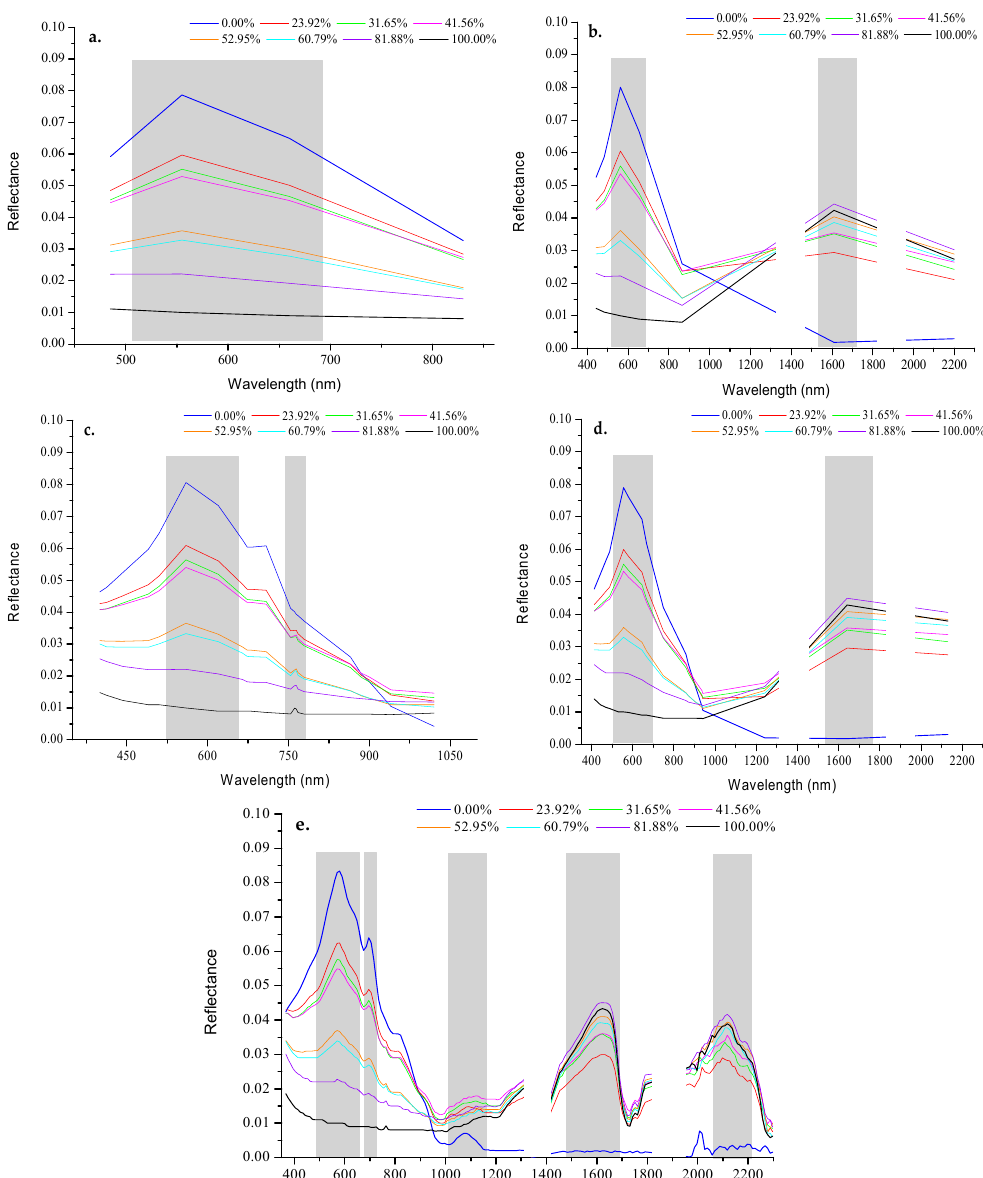
Figure 11. Reflectances of oil-polluted sea ice resampled to the band settings of select sensors. GF-2 ( a ); Landsat8-OLI ( b ); Sentinel3-OLCI ( c ); MODIS ( d ); and, AVIRIS ( e ).